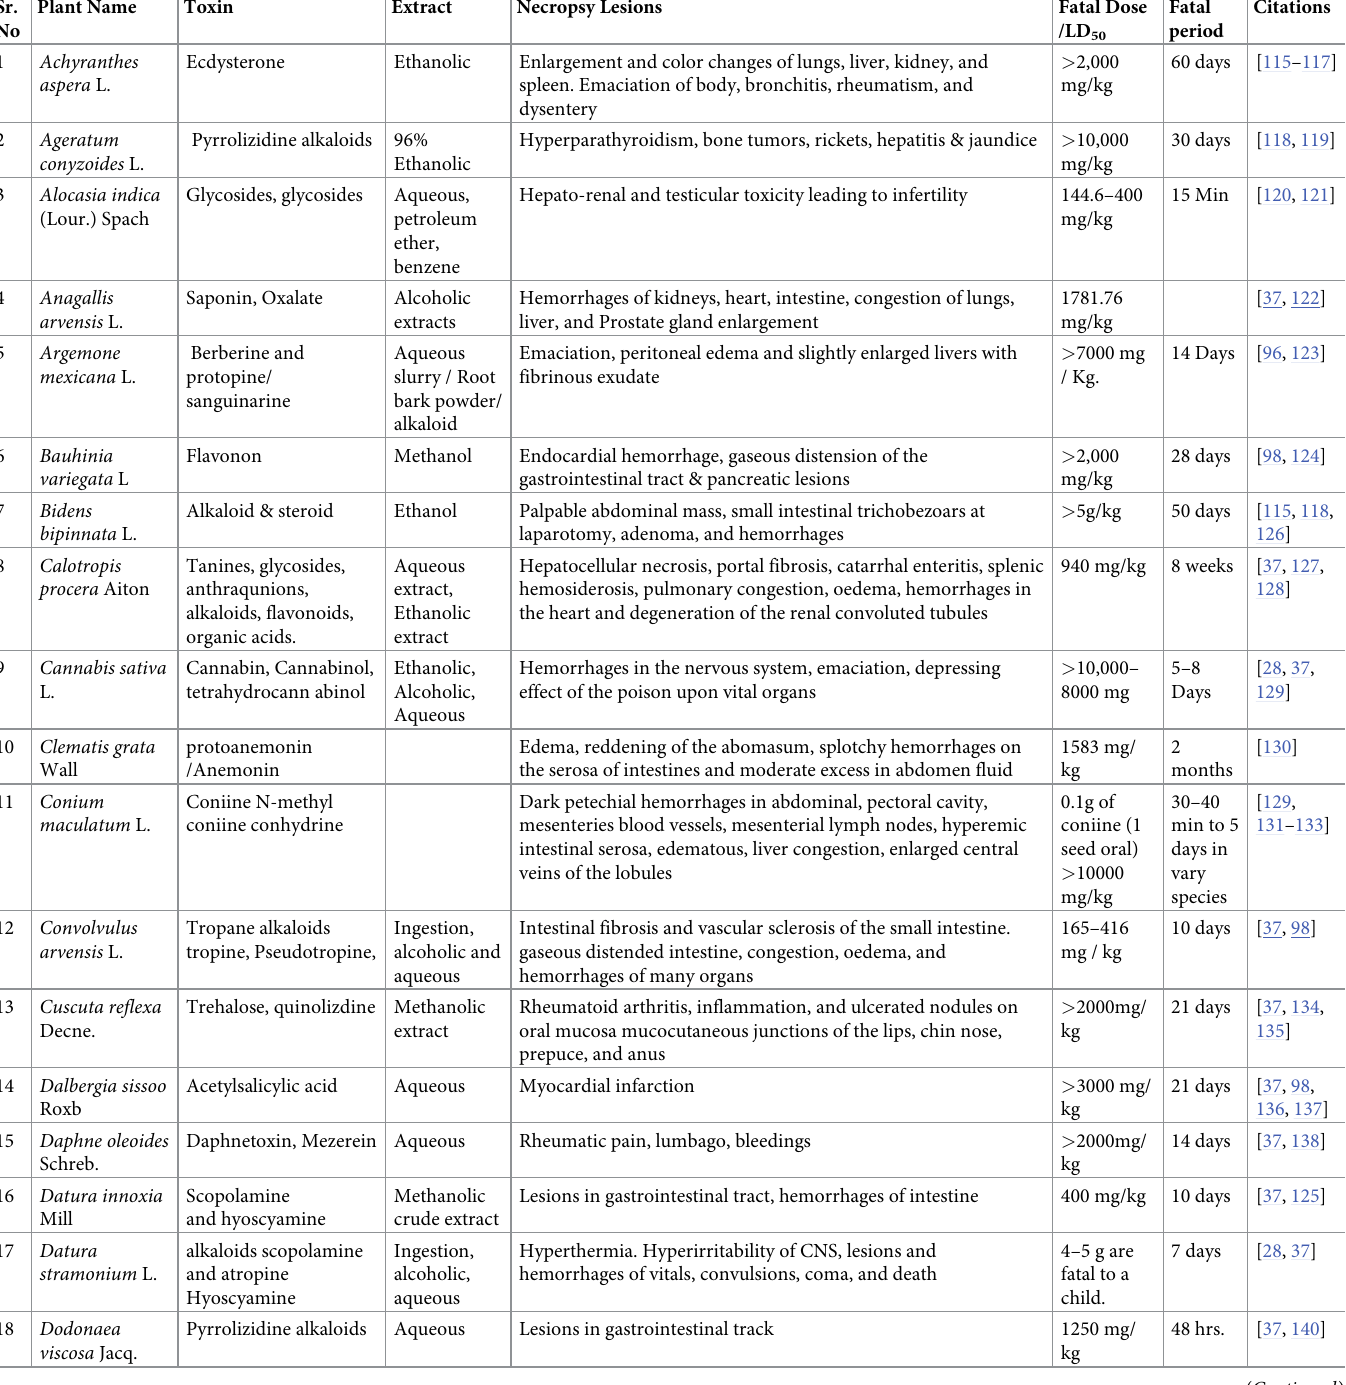
Table 4. Principal toxin, necropsy lesions and fatal dose (LD50) of the selected poisonous plants from the study area. Sr. Plant No